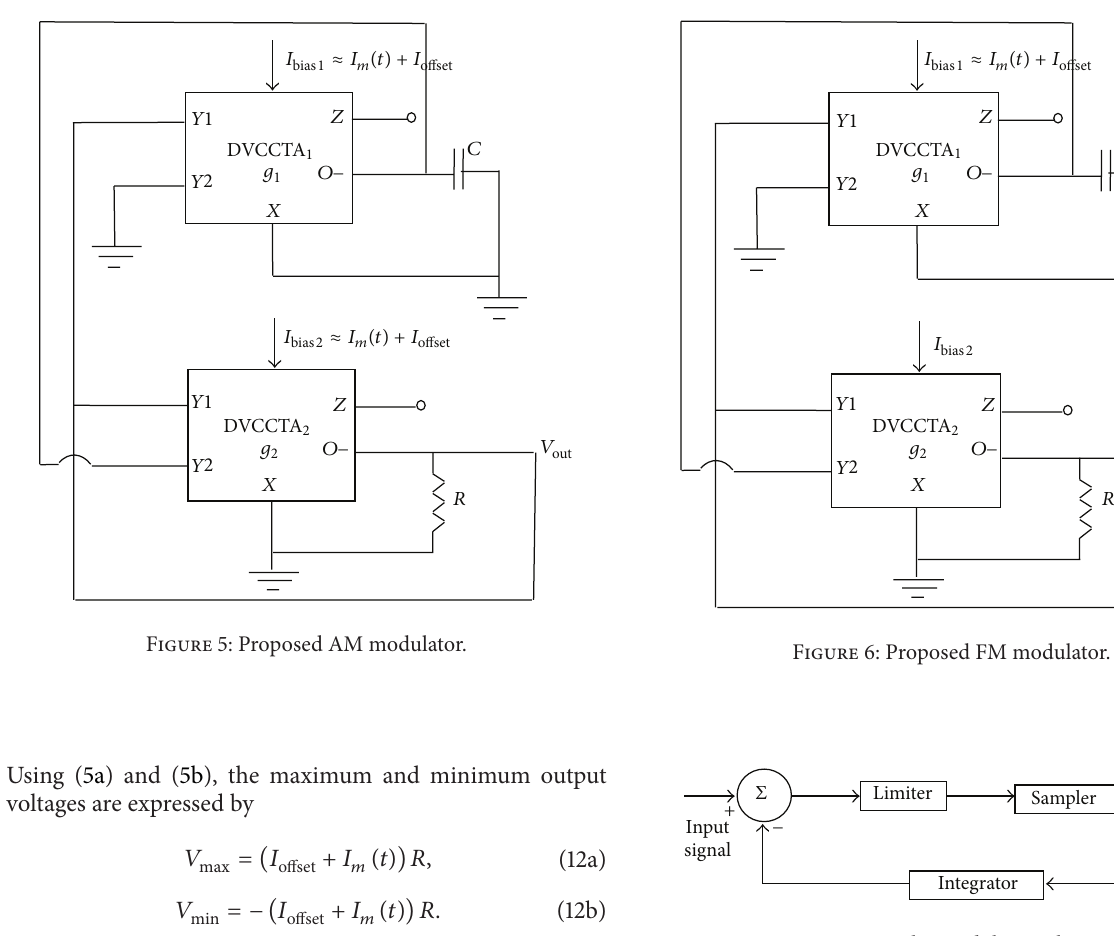
Figure 7: Delta modulator